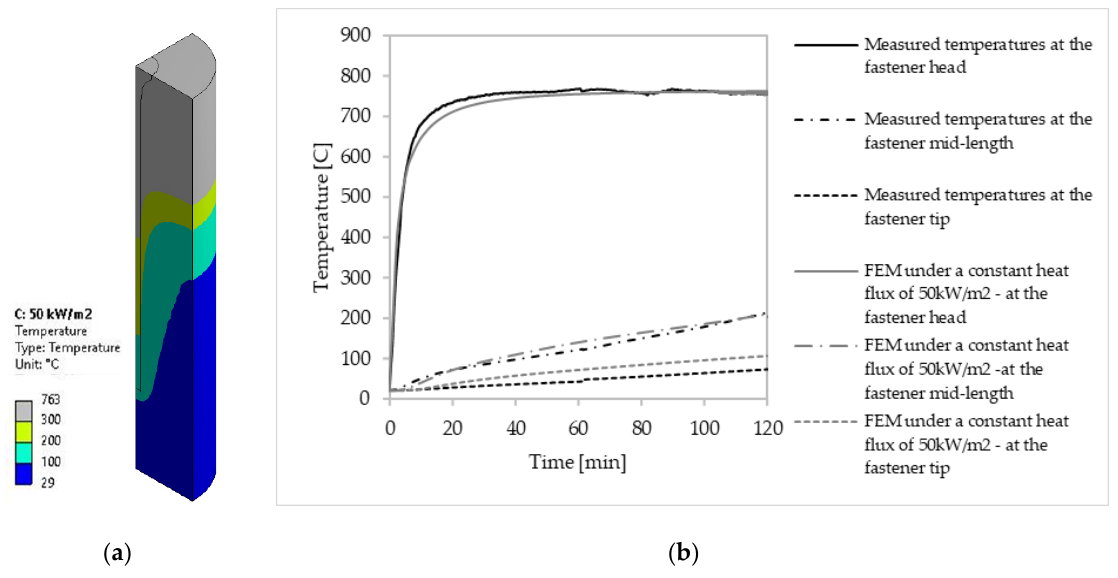
Figure 15. Numerical modelling of a Ø 10 mm full-thread STS exposed to a constant heat flux of 50 kW/m 2 : ( a ) Heat transfer model at two hours of exposure; ( b ) Comparison of numerical and experiment of time–temperature curves up to two hours of exposure.